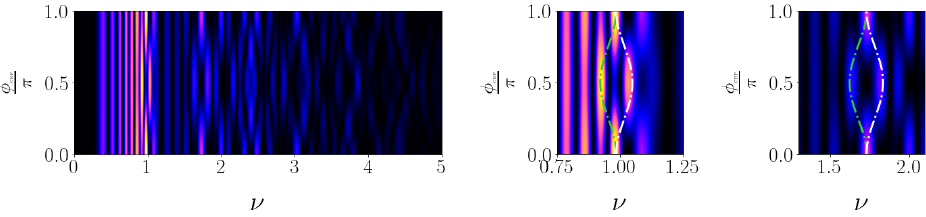
Figure 3. On-axis spectrum as a function of φ cep for a linearly polarized pulse with a 0 = 2 and N c = 5. The middle and right panels are cutouts of the left graph for the third and fifth harmonics along with lines according to Equation (8). The spectrum has a φ cep dependency because the same frequency is emitted at different times during the interaction. We can see that the spectrum is symmetric around φ cep = π , thus there is not a unique solution to the frequency shift due to φ cep (e.g., ∆ ν 2 ) = ∆ ν ( φ cep = 3 π ) ). Therefore, the interval for which φ cep can be determined from a given = π , cep 4 4 H ] + k π spectrum is [ 0, π , where k is an 2 2